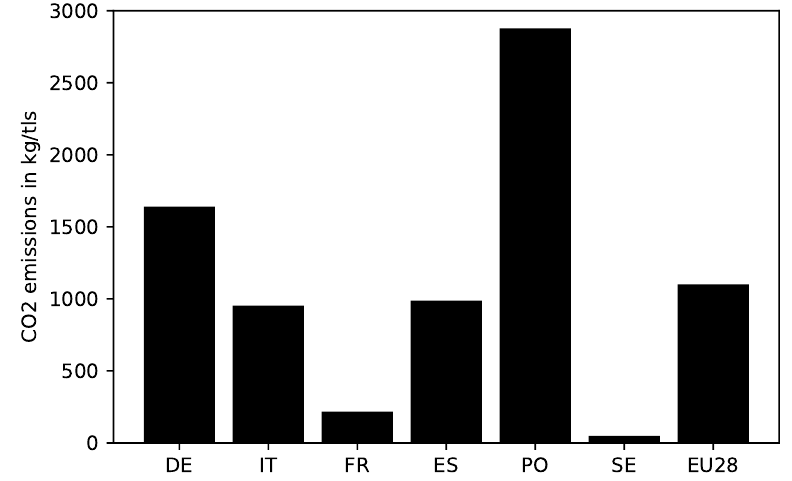
Figure 11. CO 2 emission variation with countries in